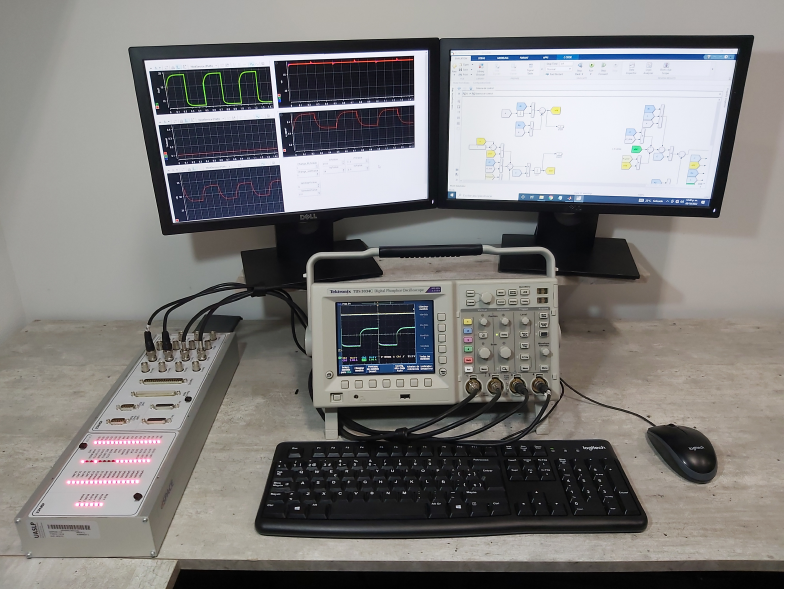
Figure 5. Real-time numerical simulations through DSPACE DS1104, computer, and oscilloscope TDS